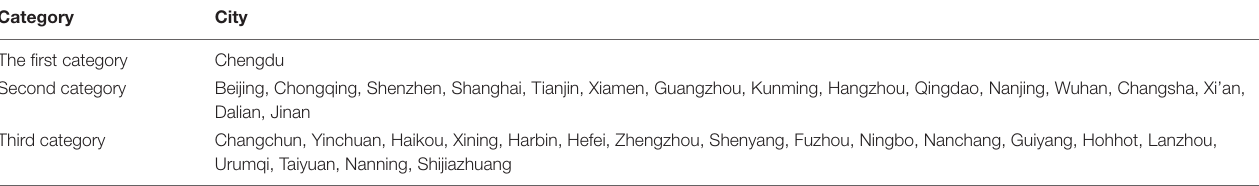
TABLE 5 | Classification and summary of the social development of 35 large and medium-sized cities in the 2016–2020 period. Category City